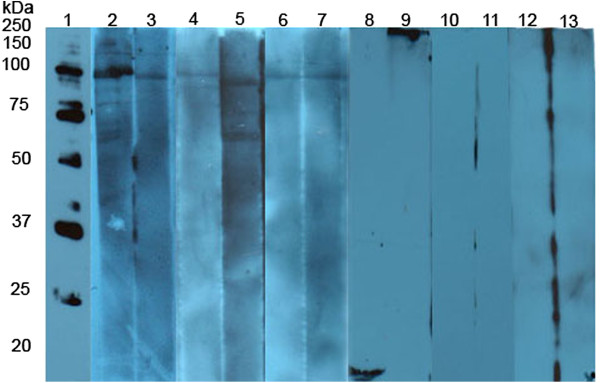
Representative IgG, IgG1and IgG4blots of rPPDK probed with human serum samples. Lane 1: Precision Plus Protein™ Unstained Standard Marker (Bio-Rad, USA); Lanes 2 to 3: individual serum samples from patients with ALA probed with IgG; Lanes 4 to 5: individual serum samples probed from patients with ALA probed with IgG1, Lanes 6 to7: individual serum samples from patient with ALA probed with IgG4; Lanes 8, 10 and 12: negative serum samples from healthy individuals probed with IgG, IgG1 and IgG4, respectively; Lanes 9, 11 and 13: negative serum samples from other disease probed with IgG, IgG1 and IgG4, respectively.